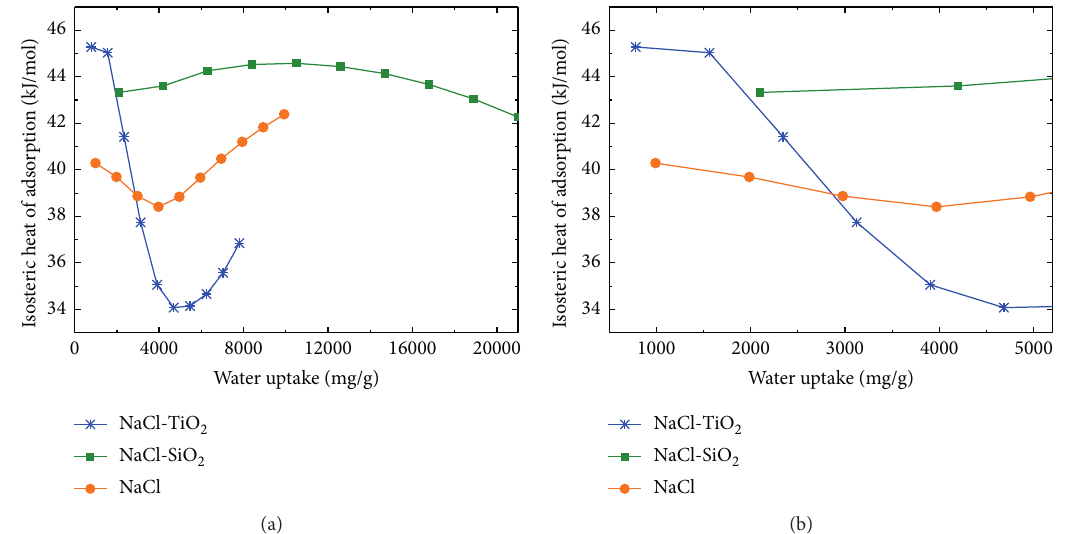
2 , and (c) NaCl-SiO 2 .